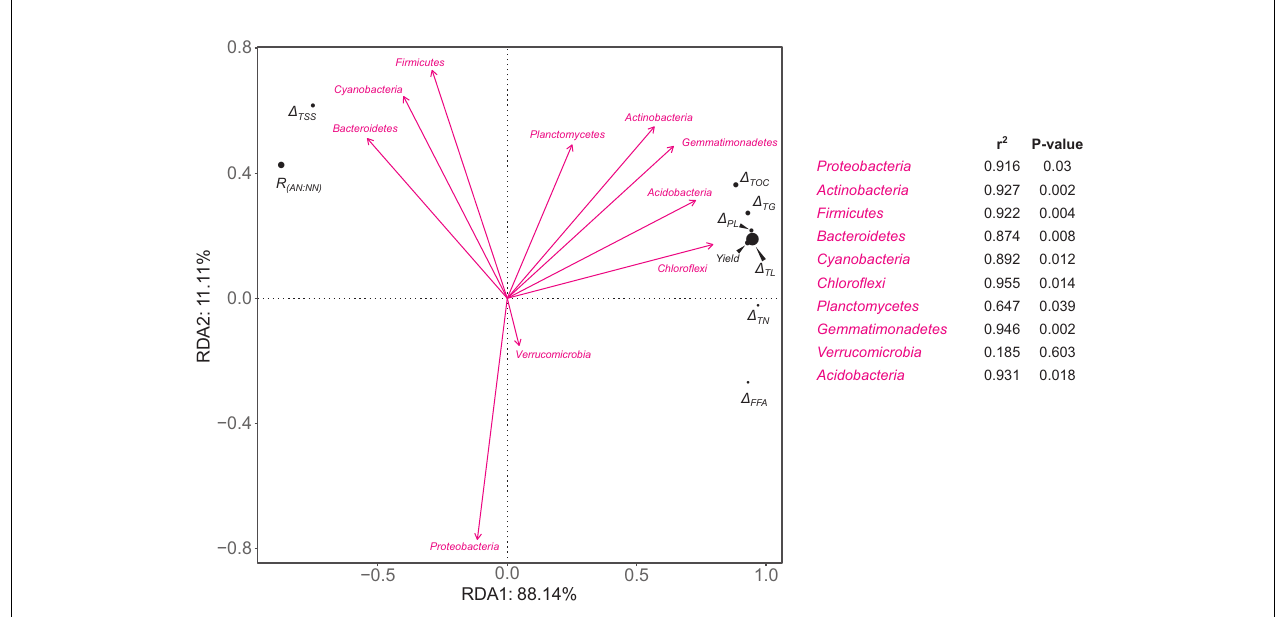
FIGURE 6 | RDA plots of the relative abundances of bacterial phyla versus ecophysiological factors involved in fructification-related metabolism of C and N nutrients. The relative abundance of each bacterial phylum is an average value of day 90 and 135. (cid:49) TOC , (cid:49) TSS , (cid:49) TL , (cid:49) TG , (cid:49) PL , (cid:49) FFA , and (cid:49) TN mean the consumed amounts (the difference between day 90 and 135) of total organic C, total soluble sugars, total lipids, total triglycerides, total free fatty acids, total phospholipids, and total N, respectively. R ( AN:NN ) means the ratio of ammonium-N:nitrate-N. The strength of correlation is estimated by the length of arrow in combination with the R 2 and P values calculated by Envfit